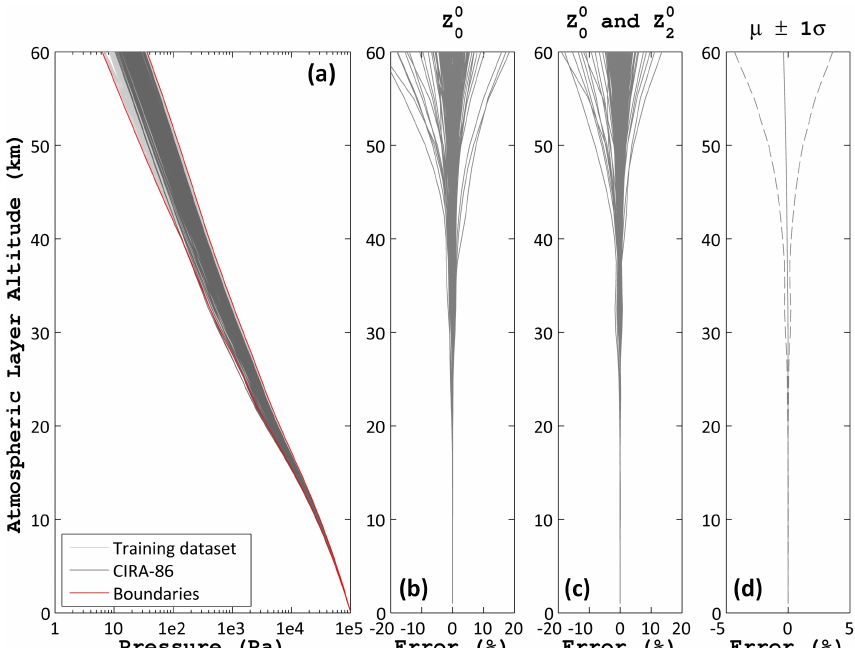
Fig. 6. Retrieval algorithm applied to the simulated sunsets for each of the 204 pressure profiles of the CIRA-86 climatology. The first panel shows the CIRA-86 profiles (dark gray) above the training dataset profiles (pale gray) on a logarithmic scale. The red lines emphasize the boundaries of the training dataset. The second panel shows the relative error of the retrieved pressure in function of altitude by using infor- mation from the first Zernike polynomial only. The third panel shows the relative error obtained with the first and fifth Zernike polynomials. The last panel shows the mean relative error µ ± 1 σ for the two Zernike polynomials retrieval